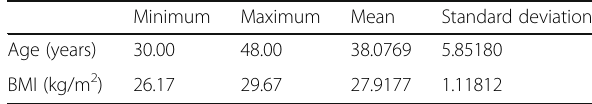
Table 1 Demographic data of participants